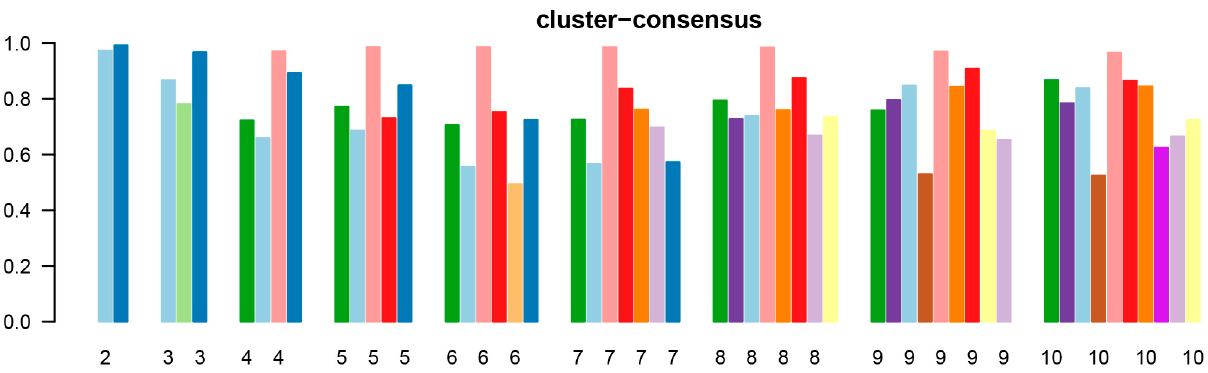
Figure 2. Mean consensus score for different numbers of clusters.